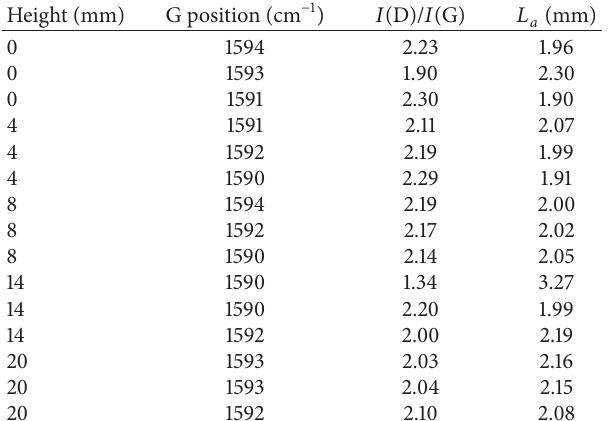
Table 2: Raman spectroscopy results from the quartz tube